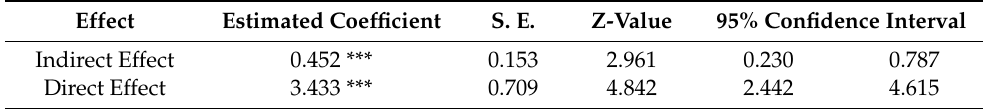
Table 3. Bootstrap test of consumption